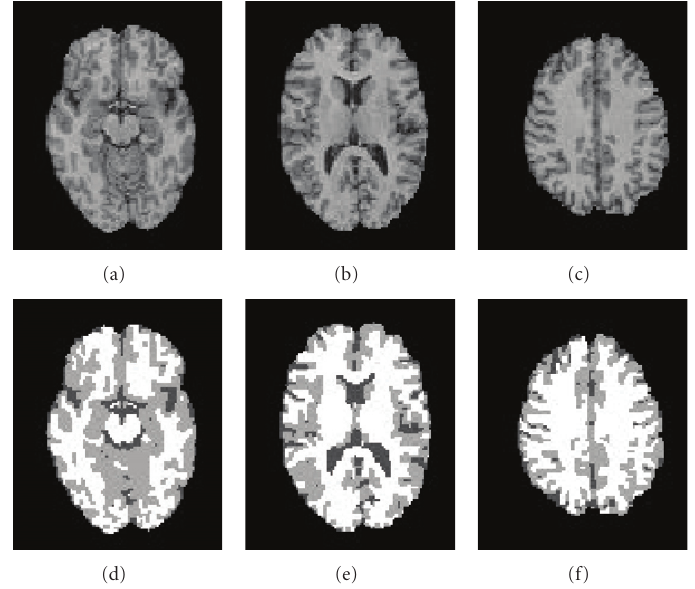
Figure 5: Examples of human brain MRI cross-sectional images. (a), (b), (c): Original MRI cross-sectional human brain images. (d), (e), (f): Unsupervised three-dimensional Markovian segmentations.